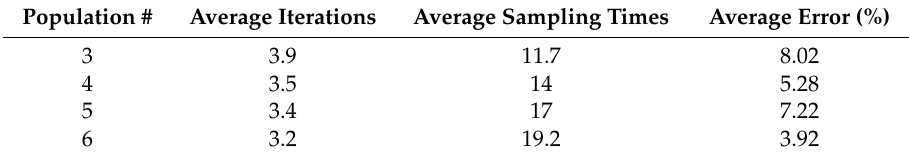
Table 7. Simulation results of the SFA with different population numbers under the 10 patterns.